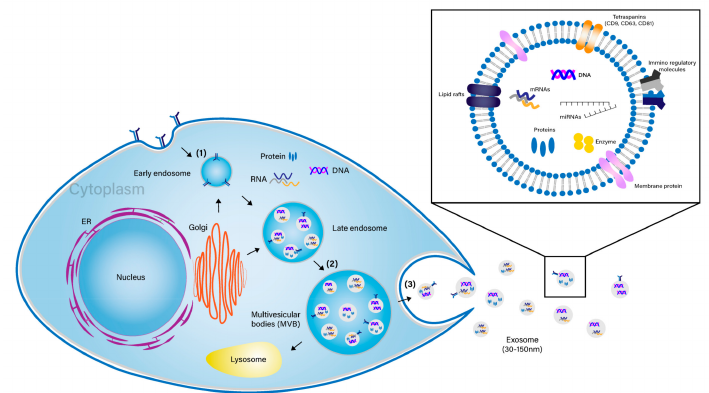
Figure 1. Production of small nano-sized membrane lipid vesicles termed “exosomes”. Exosomes are secreted by most cell types with a diameter ranging from 30–150 nm. Exosome biogenesis occurs via a few steps: (1) early endosomes undergo a series of maturation steps forming late endosomes, named multivesicular bodies (MVBs), (2) fusion of endosome-derived MVBs with the cell membrane, and (3) release of exosomes into the extracellular environment through exocytosis